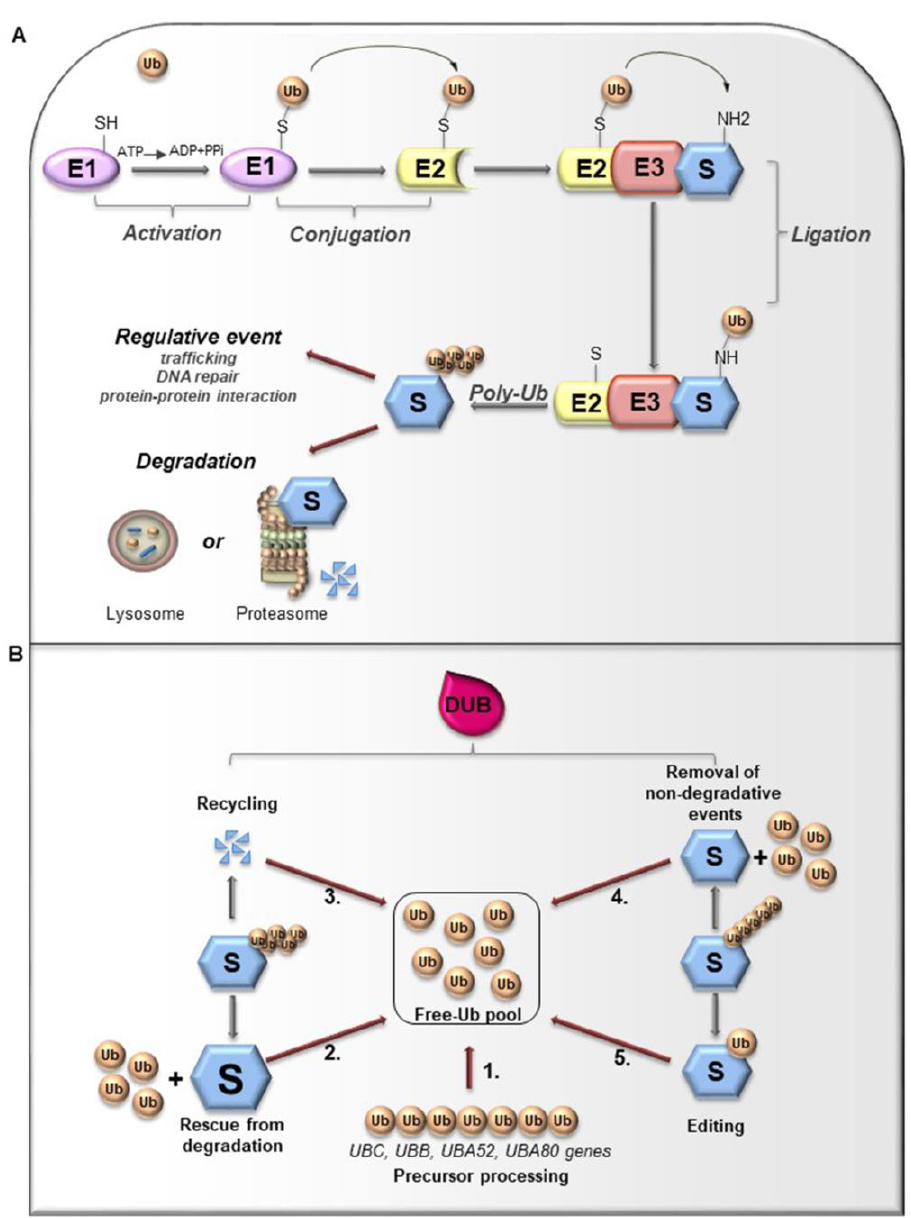
Figure 3. (A). Ubiquitylation processes. Ubiquitylation is a multi-step process that involves three enzymes: E1 (Ub-activating enzyme), E2 (Ub-conjugating enzyme) and E3 (Ub-ligase). Initially, Ub